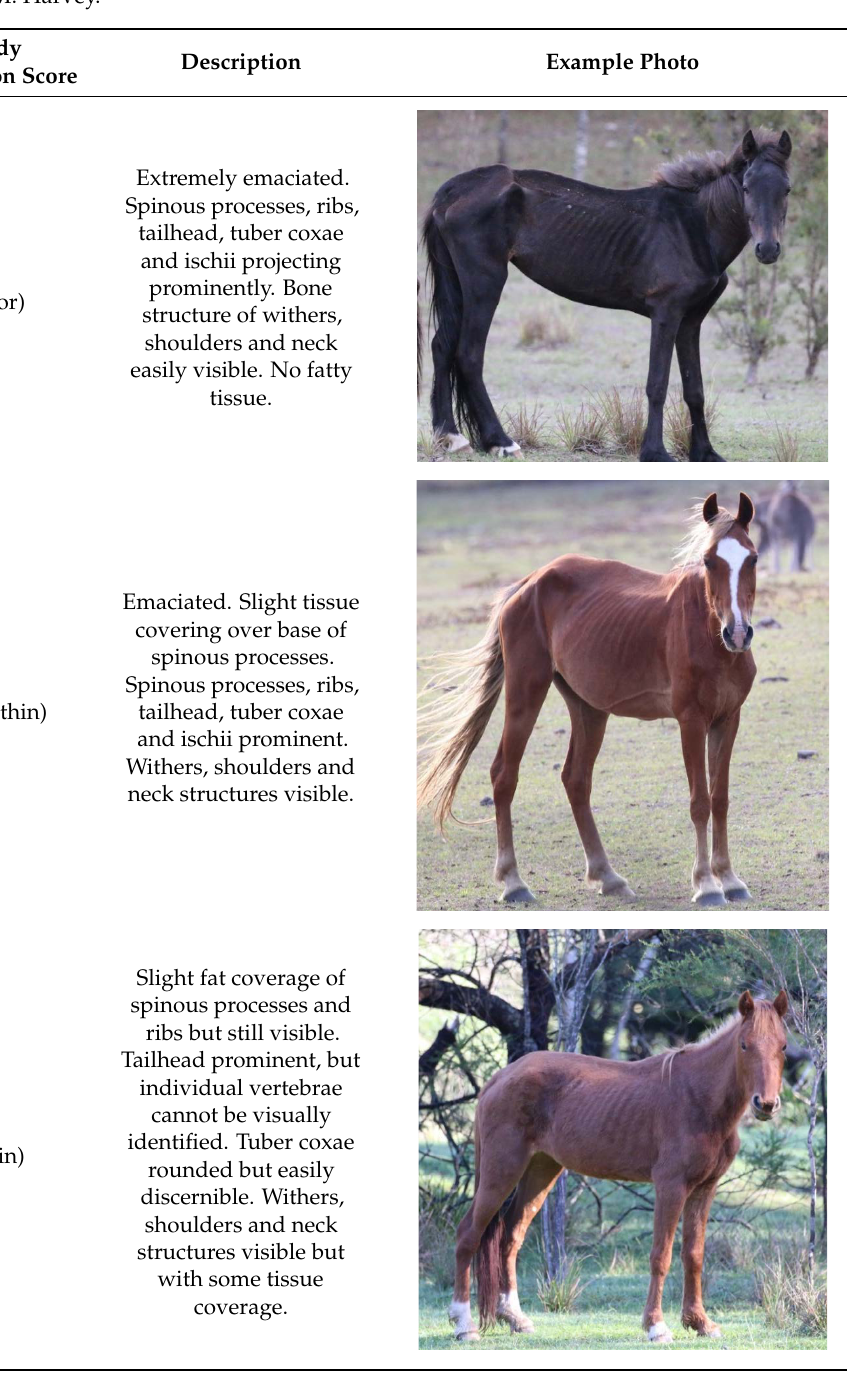
Table 3. The Henneke 9-point body condition scoring scale (adapted from Henneke et al., 1983 [65]). Images A. M.